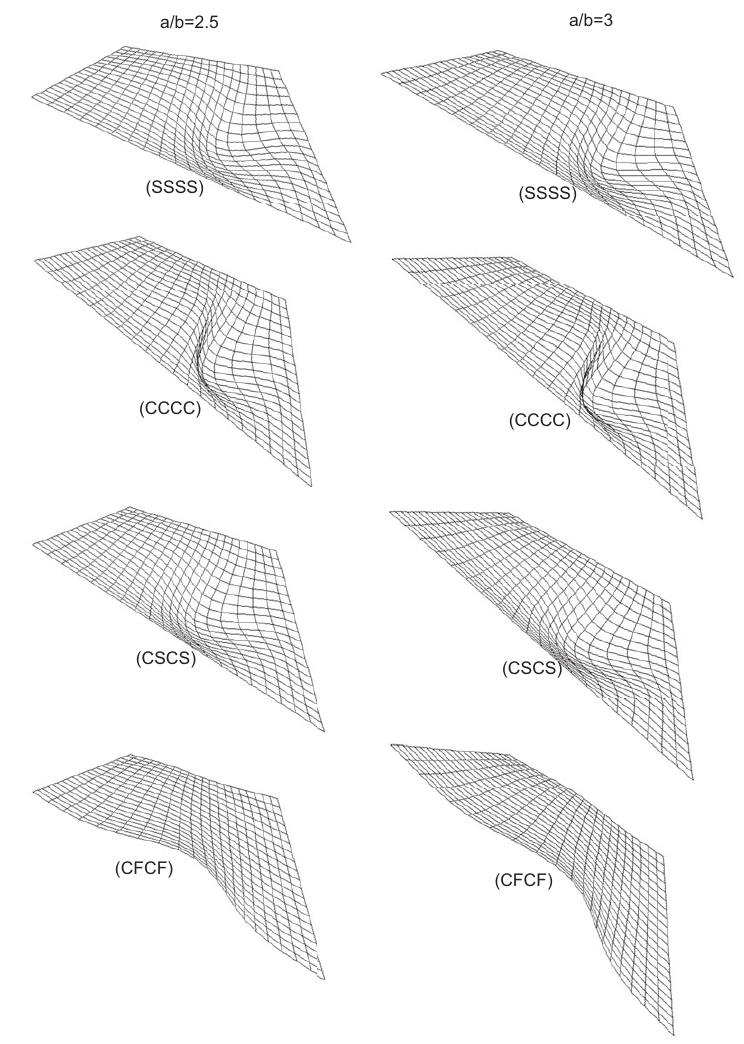
Figure 3 Mode shapes for aspect ratios and boundary conditions for general quadrilateral laminated